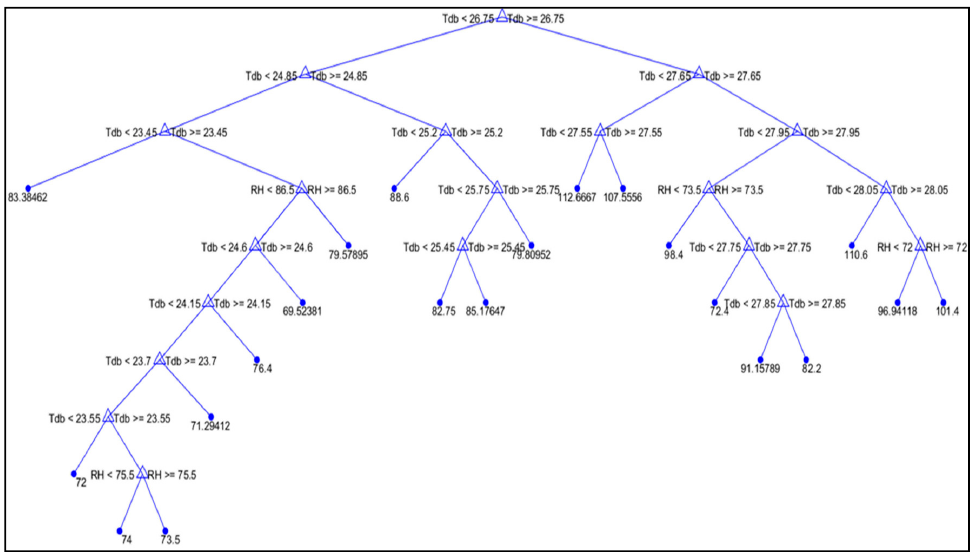
Figure 2. Visual decision tree for the RR output variable (mov.min − 1 ).